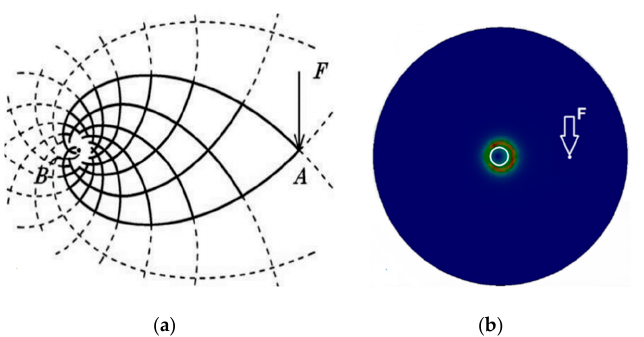
Figure 2. ( a ) The force F acting perpendicularly to the line joining the points AB (the lines indicate the principal stress directions) [4] and ( b ) The actual stress distribution from inserting the fixed circle of the continuum, simulated in the 3D program.